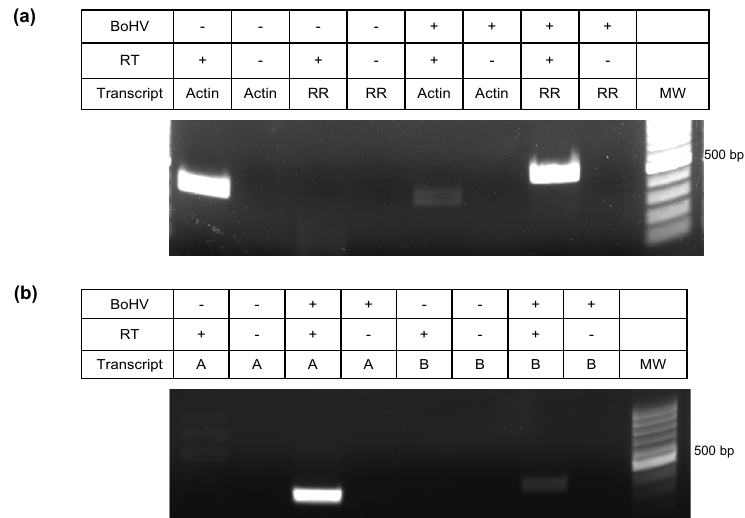
Figure 3. RT-PCR for two intergenic sequences. ( a ) PCR for cellular gene actin and viral gene ribonucleotide reductase (RR) on mock and cells infected for 16 h. ( b ) PCR amplification was carried out using primers for putative ORF-A and ORF-B for the same mock and infected cells. RT indicates the presence (+) or absence (-) of a retrotranscriptase step with mRNA as a template.